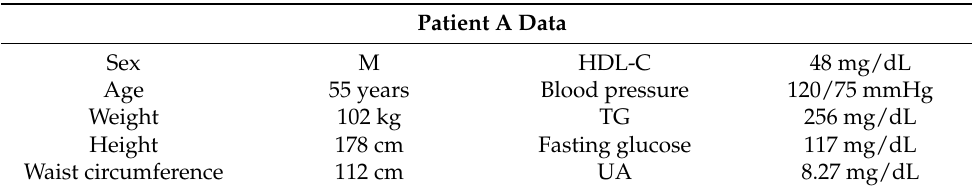
Table 5. Patient A